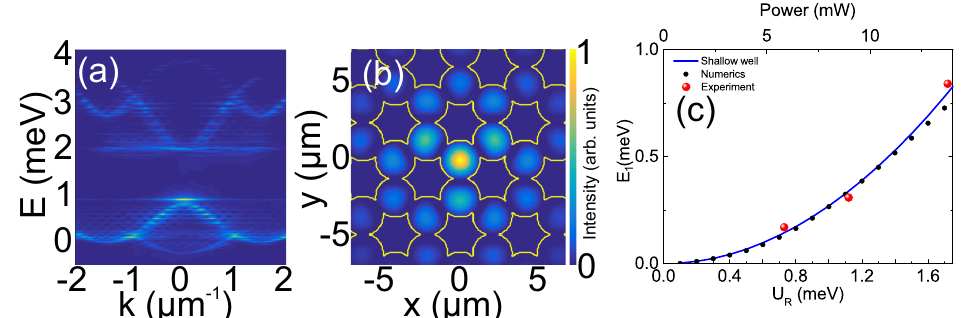
Figure 2: (a) Calculated momentum space dispersion of a lattice with an external = 0.5 mW. s- and p-bands potential localised in a single pillar with an amplitude U R as well as a gap state close to the top s-band are visible. (b) Calculated real-space emission intensity of the gap state. (c) Black dots: Calculated energy of the gap state relative to the top of the s-band as a function of the reservoir potential (lower scale). Solid line: Eq. 2. Red dots: measured energy of the gap state from the top of the s-band as a function of the excitation density (upper scale) for low excitation densities ( < 18 mW, Fig. 1(e)). The relative extent of the upper horizontal scale has been chosen to overlap the experimental points to the